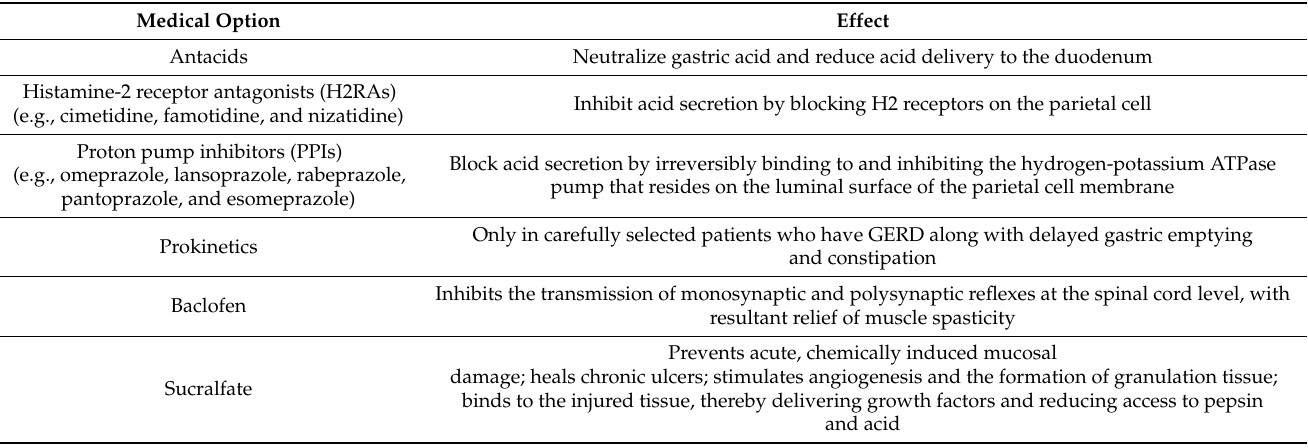
Table 1. Summary of antireflux drugs in